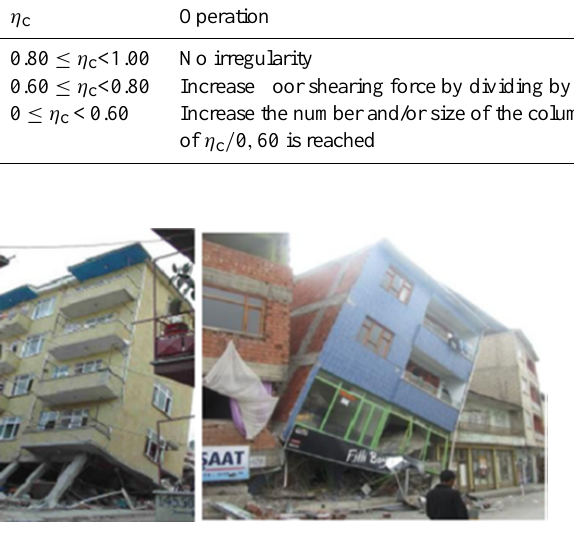
Figure 8. Examples of damage related to soft-story and weak-story irregularities (source: Ahmet Topçu).